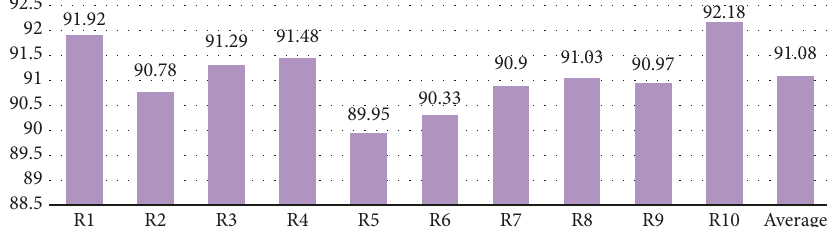
Figure 7: Results of 10 runs of the proposed method in the classification recall criterion with an average of 10